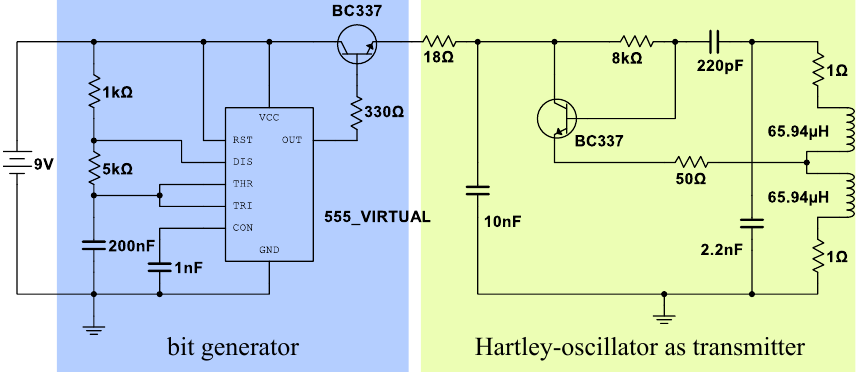
Figure 9. Transmitter circuit: bit generator based on the integrated circuit LMC555 and the Hartley- oscillator